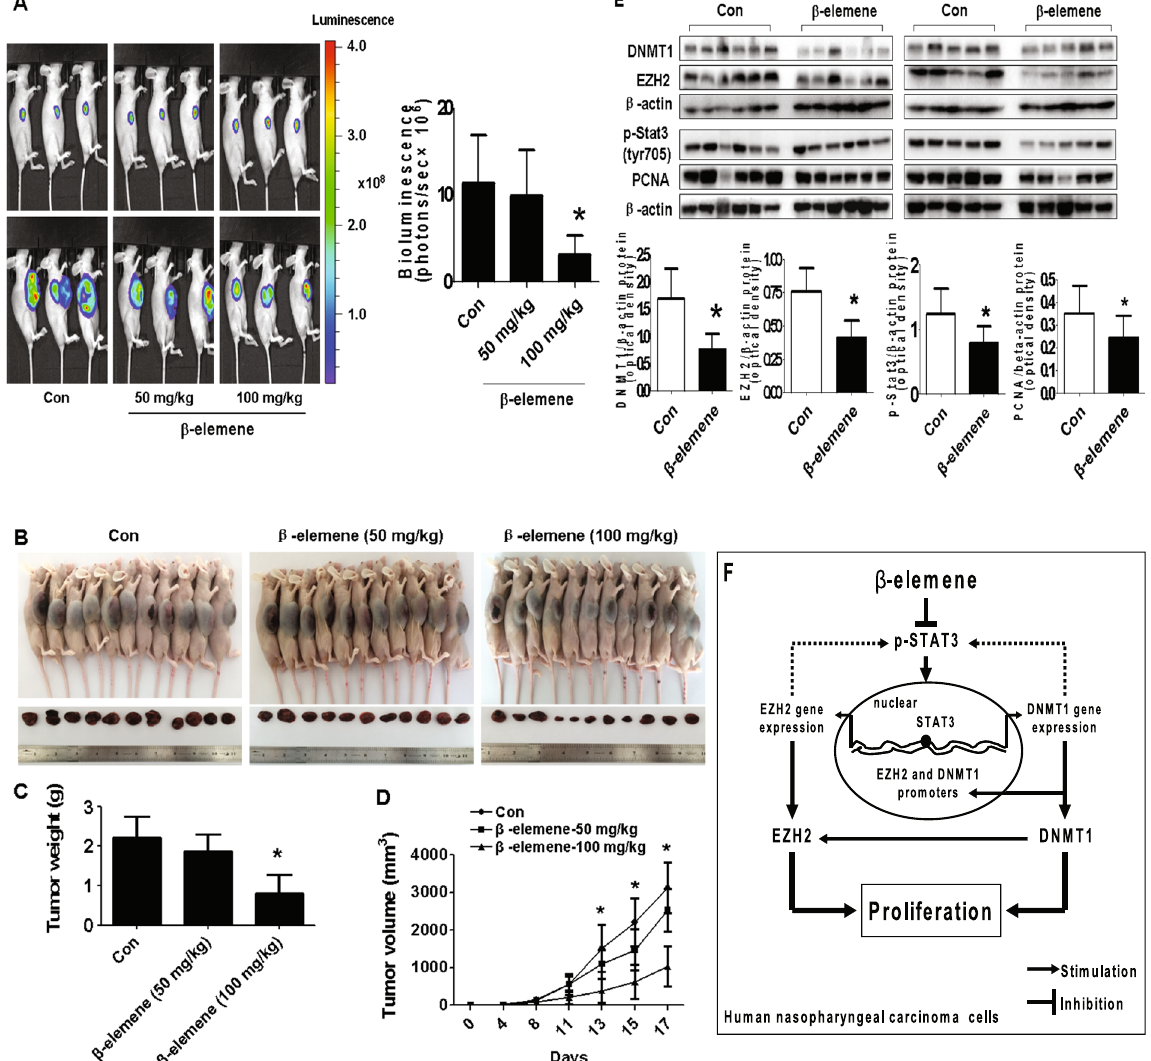
Figure 6. In vivo anti-tumor efficacy of β -elemene in subcutaneous lung tumor-bearing nude mice model. Mice (n = 11/group) were divided to 3 groups [Con (saline), Low (L, 50 mg/kg) and High (H, 100 mg/kg)], and β -elemene was given at the 10 th day after tumor cells injection by gavages for up to 17 days. ( A ) The xenografts were assessed by in vivo bioluminescence imaging at the day 1 and the end of the experiments (on day 17). The tumor growth was monitored by injecting luciferin in the mice followed by measuring bioluminescence using IVIS Imaging System. Imaging and quantification of signals were controlled by the acquisition and analysis software living image as described in the Materials and Methods section. Representative images are shown. ( B ) The photographs of β -elemene or vehicle-treated xenografts derived from nude mice are shown. ( C,D ) The xenografts were harvested on day 17, and the volume and weight of tumors were measured. ( E ) At the end of the experiments, xenografted tumors from the high dose and control groups were isolated from individual animals and the corresponding lysates were processed for detecting DNMT1, EZH2, p-Stat3, and PCNA by Western blot. β -actin was used as loading control. The bar graphs represented the tumor weight and volume of mice results of as mean ± SD. * Indicates the significant difference from the untreated control (p < 0.05). ( F ) The diagram shows that β -elemene inhibits NPC growth through inactivation of Stat3, followed by reduction of DNMT1 and EZH2 expression. The reciprocal communication between DNMT1 and EZH2, the mutual regulatory loops of Stat3 with DNMT1 and EZH2 contribute to the overall responses of β -elemene in this